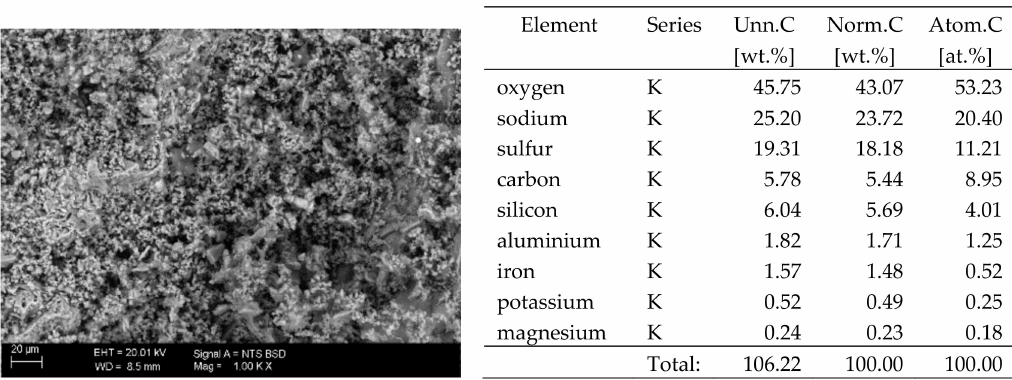
Figure 9. SEM image of the microstructure of Na 2 SO 4 crystals visible on the surface of the bricks tested; 1000 × magnification. Next to it is a screenshot an EDS analysis for presence of